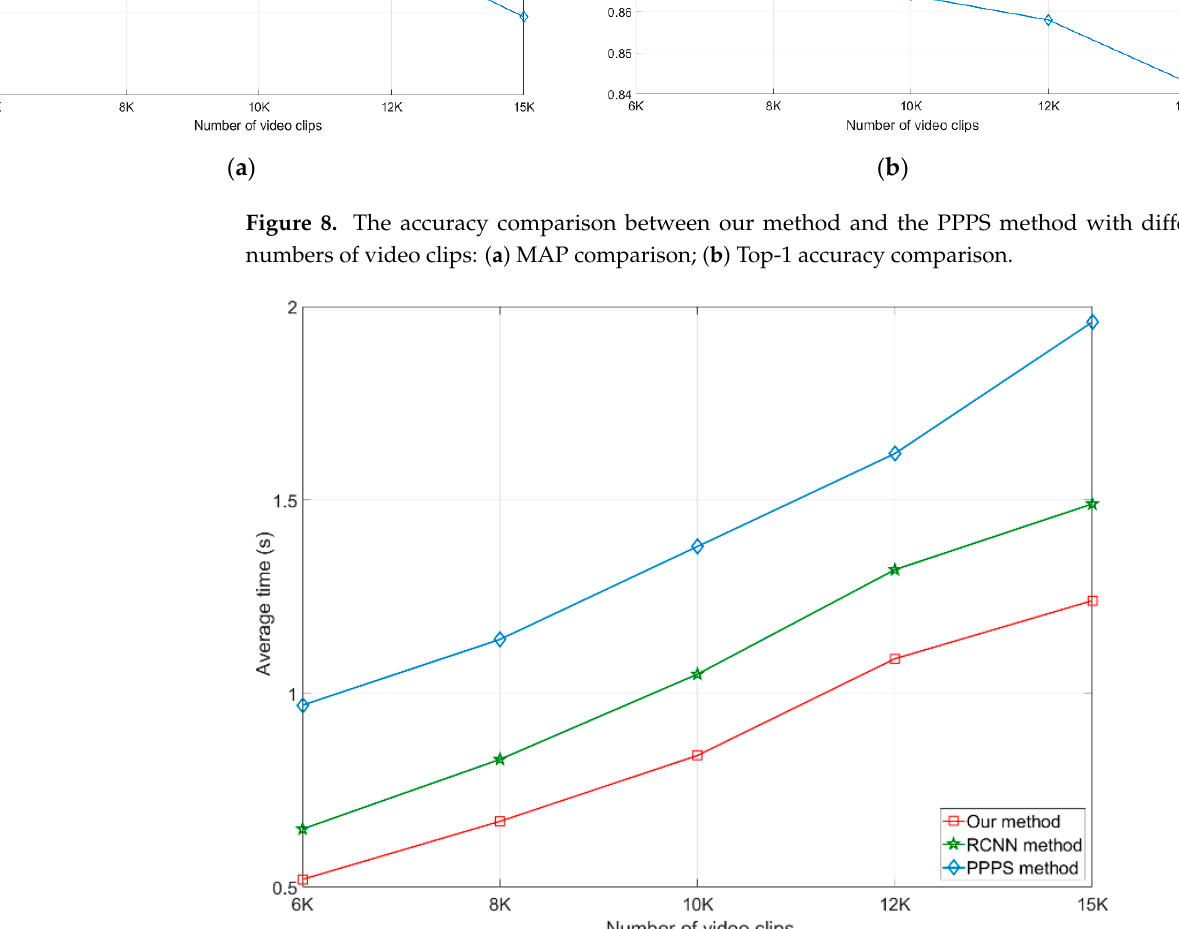
Figure 9. The efficiency comparison between our method, the RCNN method, and the PPPS method with different numbers of video clips.